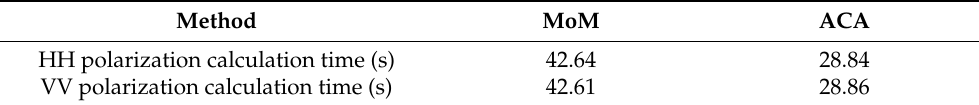
Table 1. Time comparison between MoM and ACA calculation with radius 200 nm.